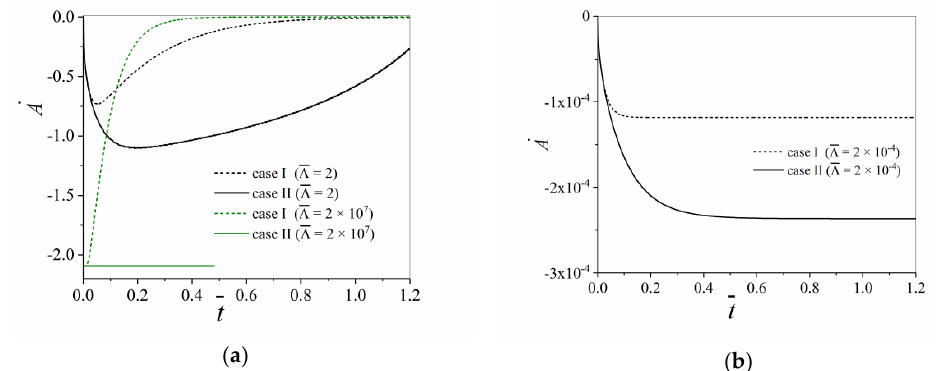
. A versus time for a 4-sided grain with different values of A : ( a ) A very Figure 9. Rate of area change Figure 9. Rate of area change A versus time for a 4-sided grain with different values of  : ( a ) A